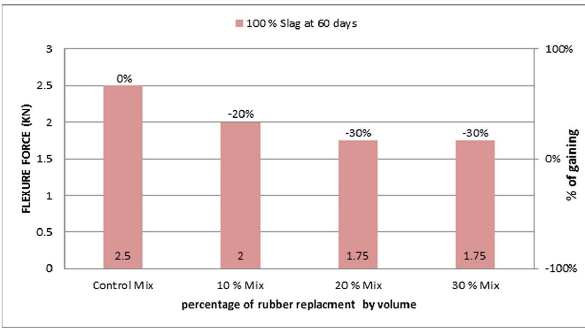
Figure 12: Flexure tensile strength for replacement of both fine and coarse aggregates of slag based geopolymer concrete with crumb rubber